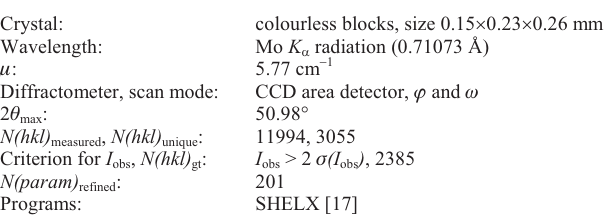
Table 1. Data collection and handling.